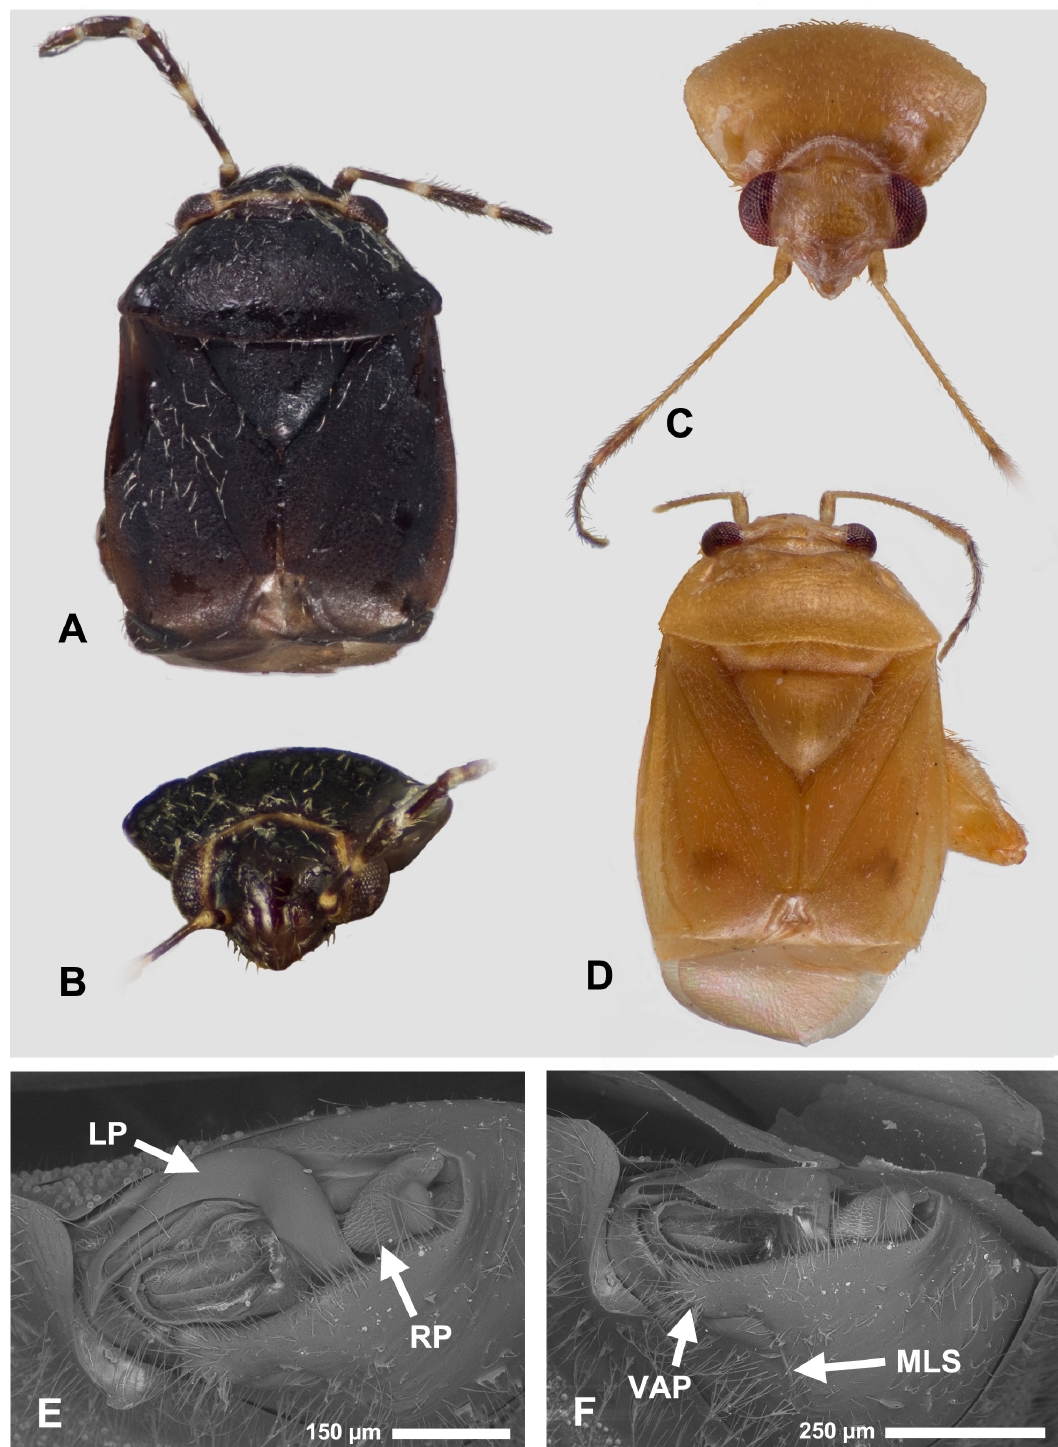
Fig. 2. Photographs and scanning electron micrographs of Coridromius eremnos sp. nov. and C. fomangsu sp. nov. — A-B . Coridromius eremnos sp. nov. A . Dorsal habitus. B . Head and pronotum, anterior view. — C-F . Coridromius fomangsu sp. nov. C . Head and pronotum, anterior view. D . Dorsal habitus. E . Male genitalia, posterior view. F . Male genitalia, posteroventral view. LP = left paramere, MLs = mesal longitudinal suture of pygophore, rP = right paramere, VaP = ventral apical process of